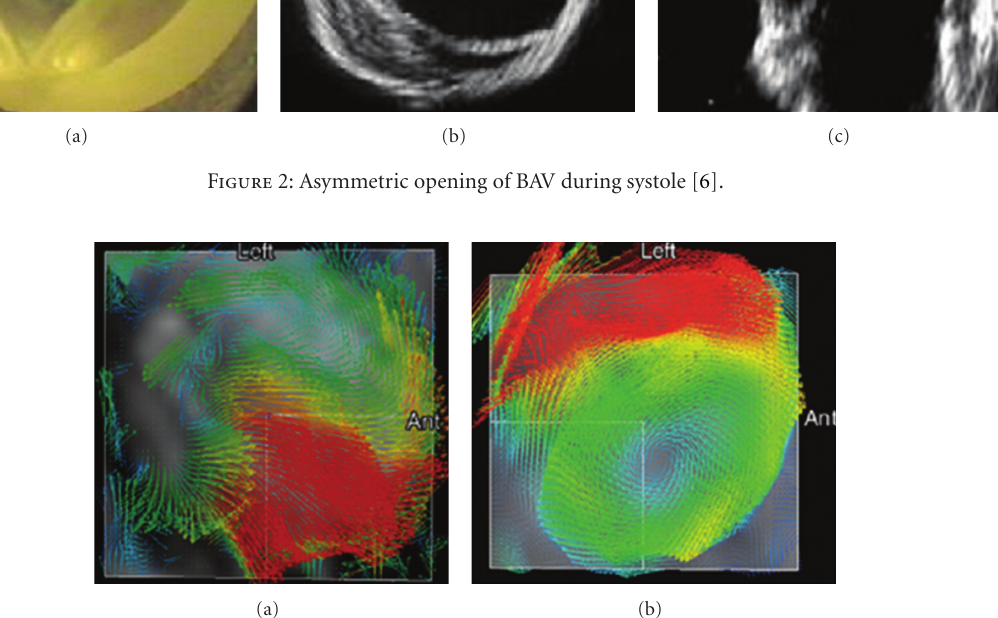
Figure 3: Unique transvalvular flow patterns in BAV patients with right-left cusp fusion (a) and right-noncoronary cusp fusion (b)